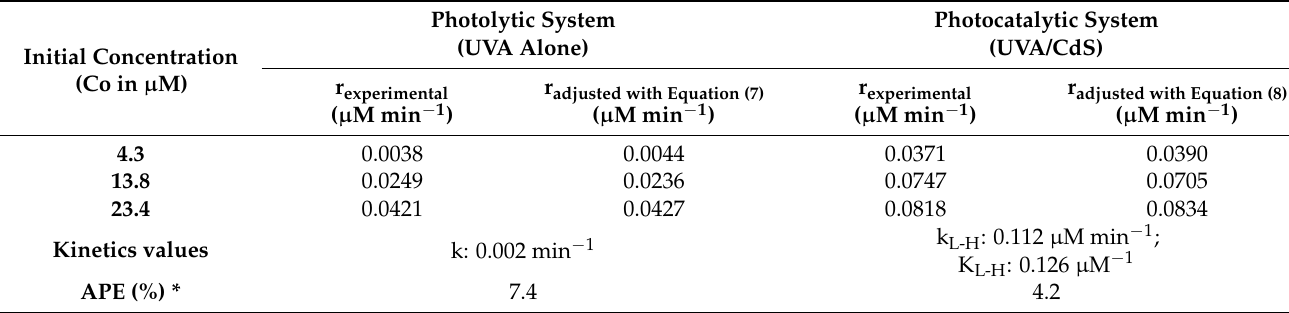
Table 1. Kinetics analyses for photolytic and photocatalytic degradation of LEV.